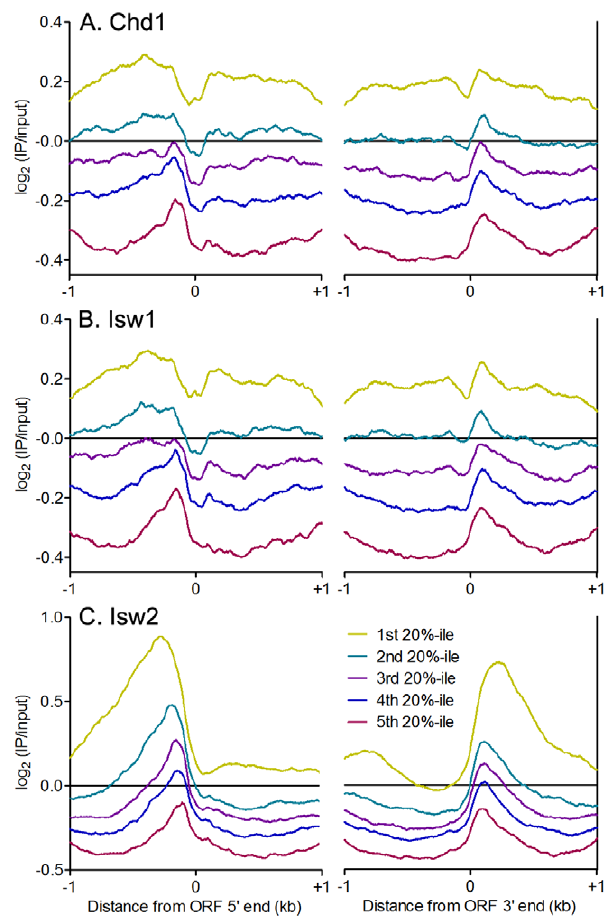
Figure 6. ISWI and CHD remodelers bind NDRs. Aggregate plots of log 2 (IP/input) signal 6 1 kb of verified ORF 5 9 and 3 9 ends for (A) Chd1, (B) Isw1, and (C) Isw2 ranked separated into quintiles by average remodeler